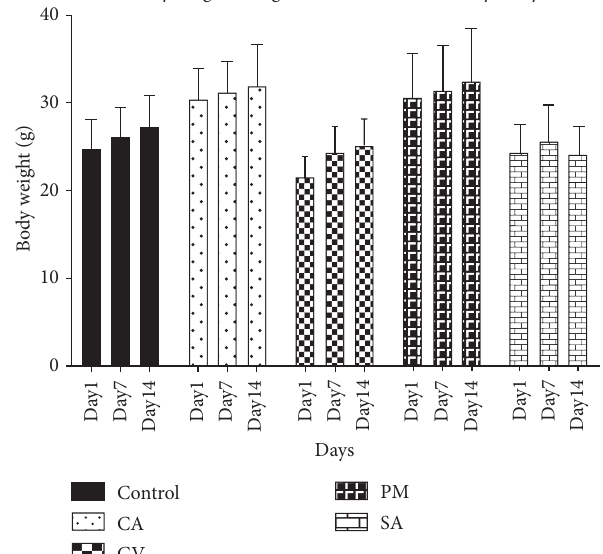
Figure 1: Body weight changes in mice in acute toxicity study. Each bar represents mean ± SEM ( n � 5). CA: Celtis africana , GV: Grosseria vignei , PM: Physalis micrantha , SA: Stachytarpheta angustifolia